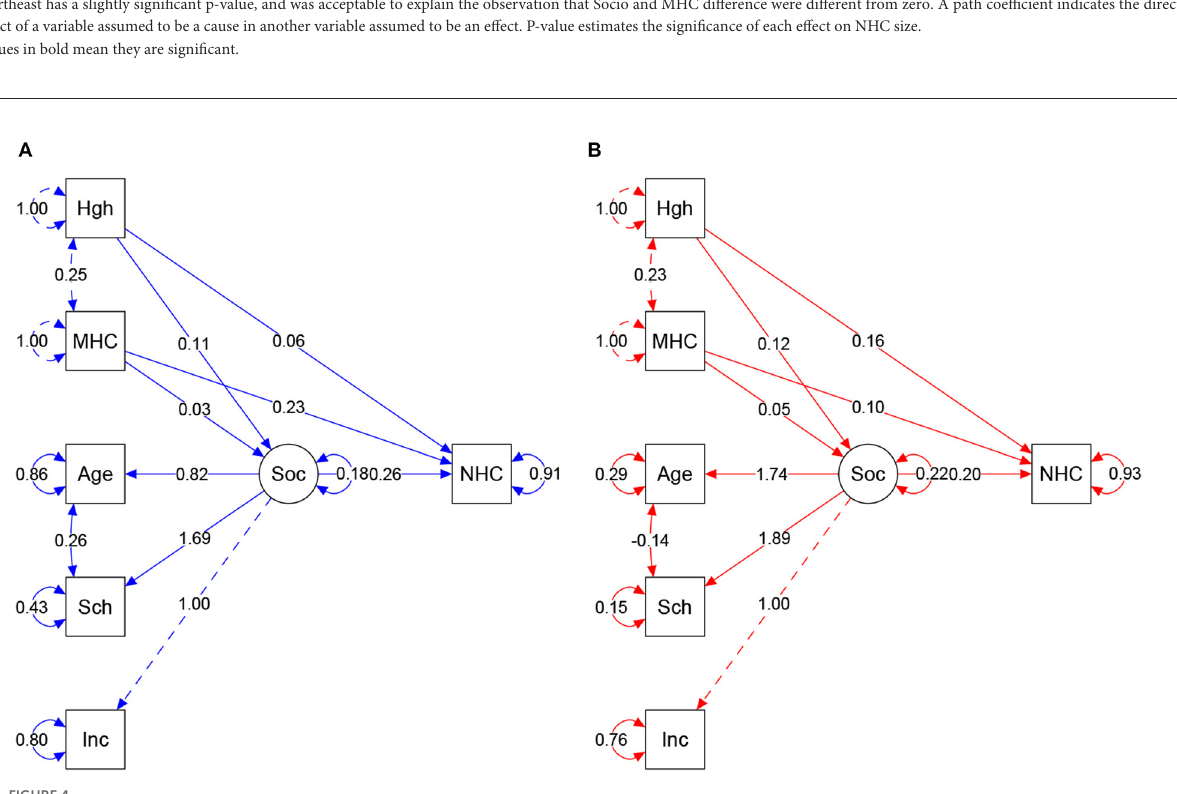
FIGURE4 (A,B) Result of structural equation model according to regions. Colors = Blue: South/Southeast, Red: Northeast. Arrow direction indicates direct and indirect effects of variables in the prediction of NHC. Values show regression and covariances among variables. Circles show standardized parameter values. MHC, Maternal HC; Sch, Schooling; Inc, Income; Soc, Socio (latent variable); NHC, Neonate HC. Model fits: South/Southeast : p -value = < 0.0001. Chi-square (X 2 ) = 0.109, Degree of Freedom (df) = 5. X 2 /df = 0.0218. CFI = 0.981. TLI = 0.946. RMSEA = 0.047 (95%CI 0.000–0.096). Northeast : p -value = < 0.0001. Chi-square (X 2 ) = 0.130. df = 5. X 2 /df = 0.026. CFI = 0.991. TLI = 0.976. RMSEA = 0.039 (IC 95% 0.000–0.083). Plausibility indexes were considered capable of showing the influence of variable interaction, explaining the proportion of